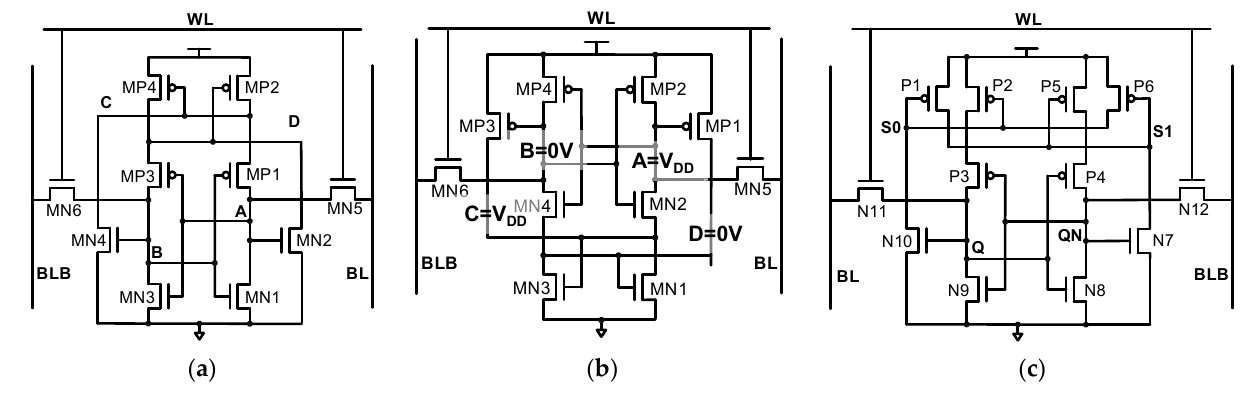
Figure 4. Schematic of ( a ) PS-10 T, ( b ) NS-10 T, and ( c ) RHD-12 T SRAM cell.